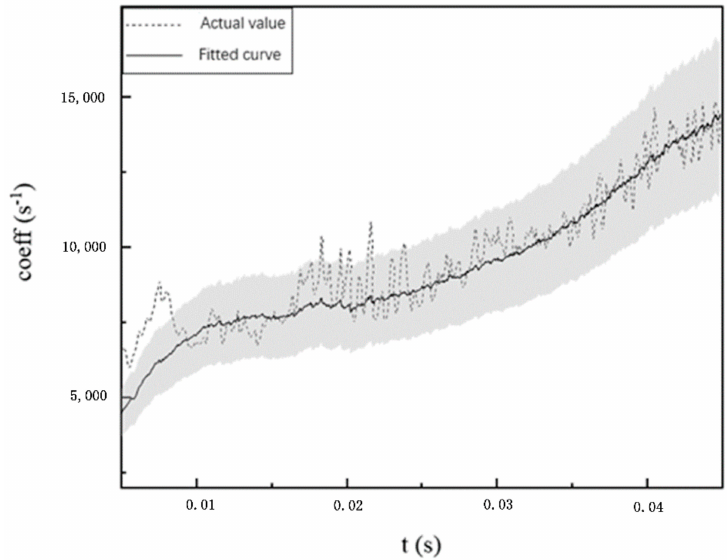
Figure 2. Fitted curve and actual value of coe ff